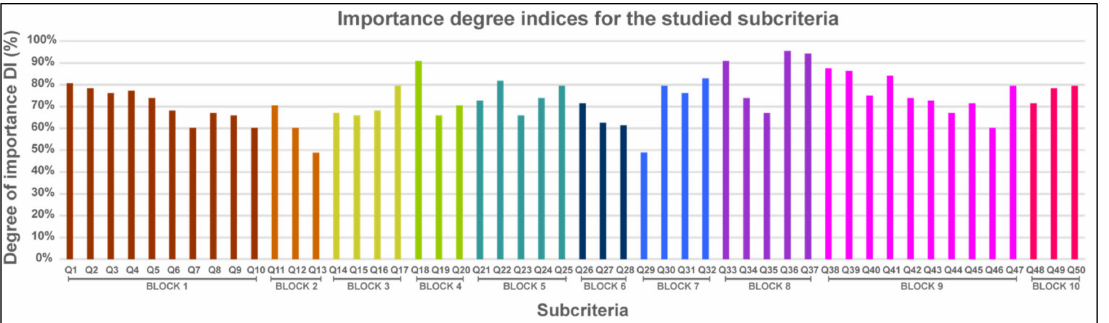
Figure 2. Bar chart showing the degree of importance (DI) of all criteria analysed (Q1 to Q50) by the experts consulted. Own elaboration.